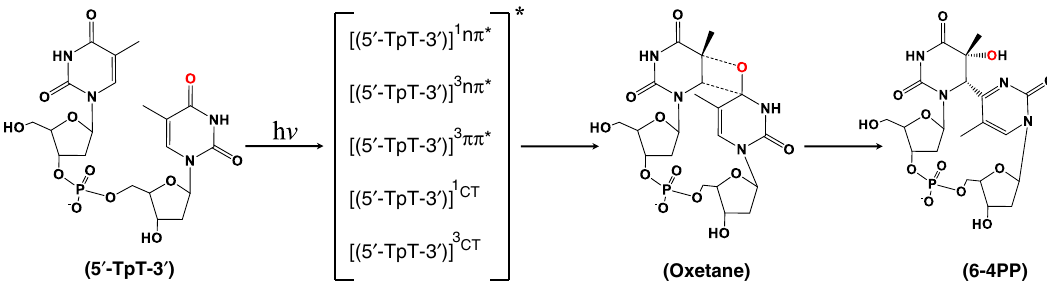
Fig. 1 Literature-proposed excited-state precursors of the oxetane intermediate 2 – 5,10 – 21,28 . 5 ′ -TpT-3 ′ represents a thymine – thymine DNA dinucleotide, while 6-4PP represents the fi nal (6 – 4) pyrimidine – pyrimidinone adduct formed after DNA absorbs ultraviolet radiation. The 5 ′ -TpT-3 ′ structure was chosen as a representative DNA structure for simplicity with the purpose of highlighting that two thymidine bases need to be close to each other for the reaction to occur. This fi gure does not imply that the reaction is limited to a dinucleotide, but it can also occur in single- and double-stranded oligonucleotides. The oxygen atom involved in the initial [2 + 2] cycloaddition reaction is highlighted with red color. CT stands for charge